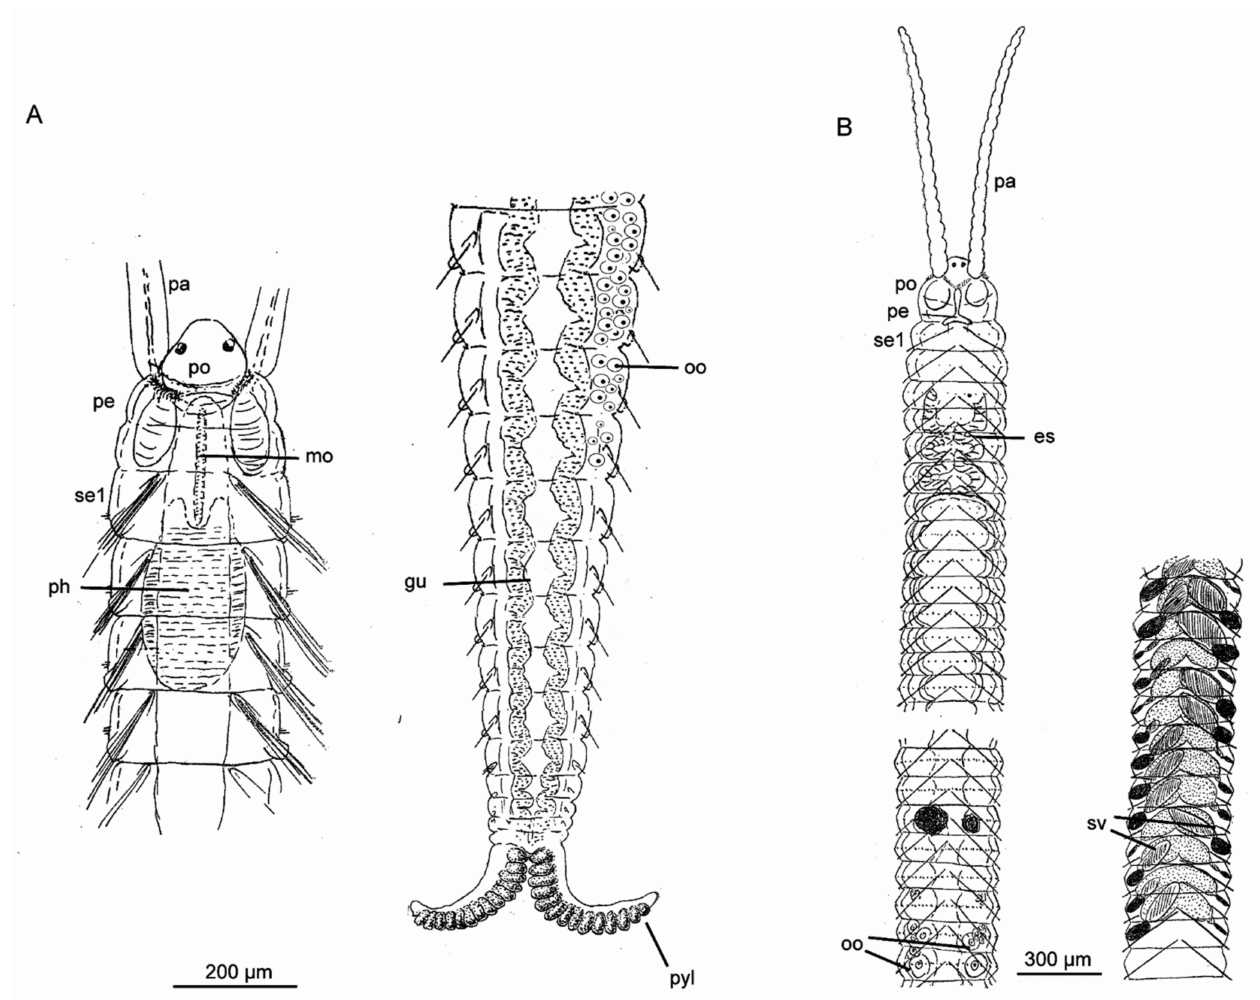
Figure 15. Saccocirridae species. ( A ) Drawing of Pharyngocirrus gabriellae , showing a female with an unpaired reproductive system and oocytes arranged on the right side of the gut (dorsal view). ( B ) Drawing of Saccocirrus pussicus showing the paired reproductive system of a female (oocytes) and a male (seminal vesicule). Abbreviations: es, esophagus; gu, gut; mo, mouth opening; oo, oocytes; pa, palps; pe, peristomium; ph, pharynx; po, prostomium; pyl, pygidial lobe; se1, segment 1; sv, seminal vesicle. References: Drawing ( A ) is modified from [260], and drawing ( B ) is modified from [108], acknowledging copyright permissions from